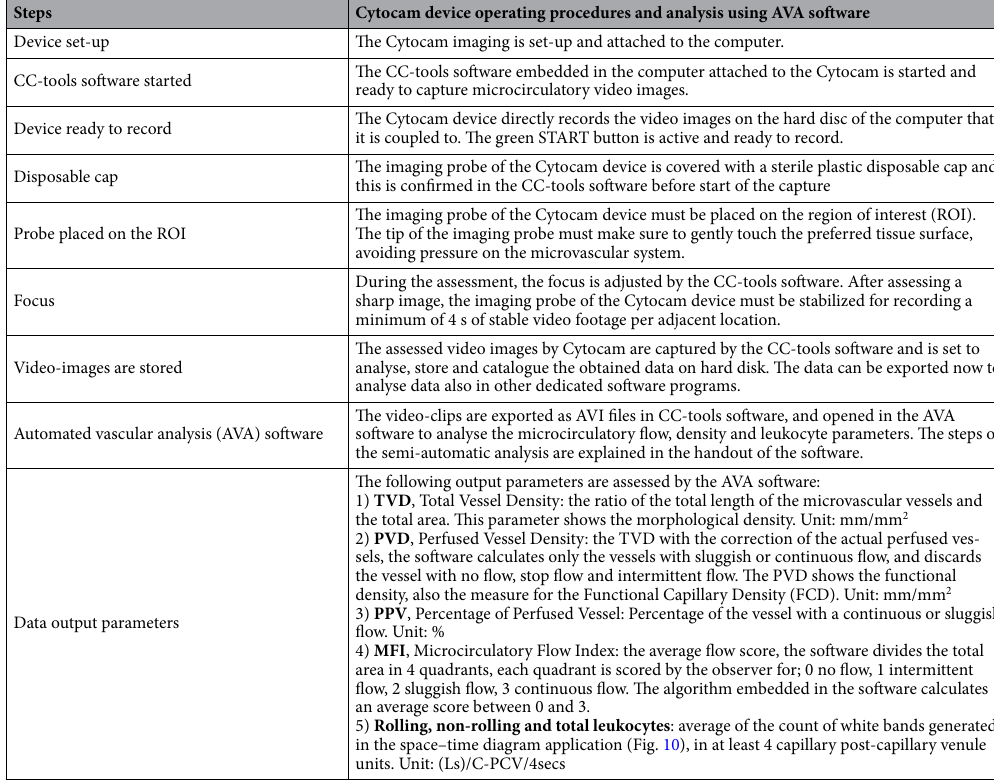
Table 5. Workflow: from Cytocam assessments to analysis using AVA